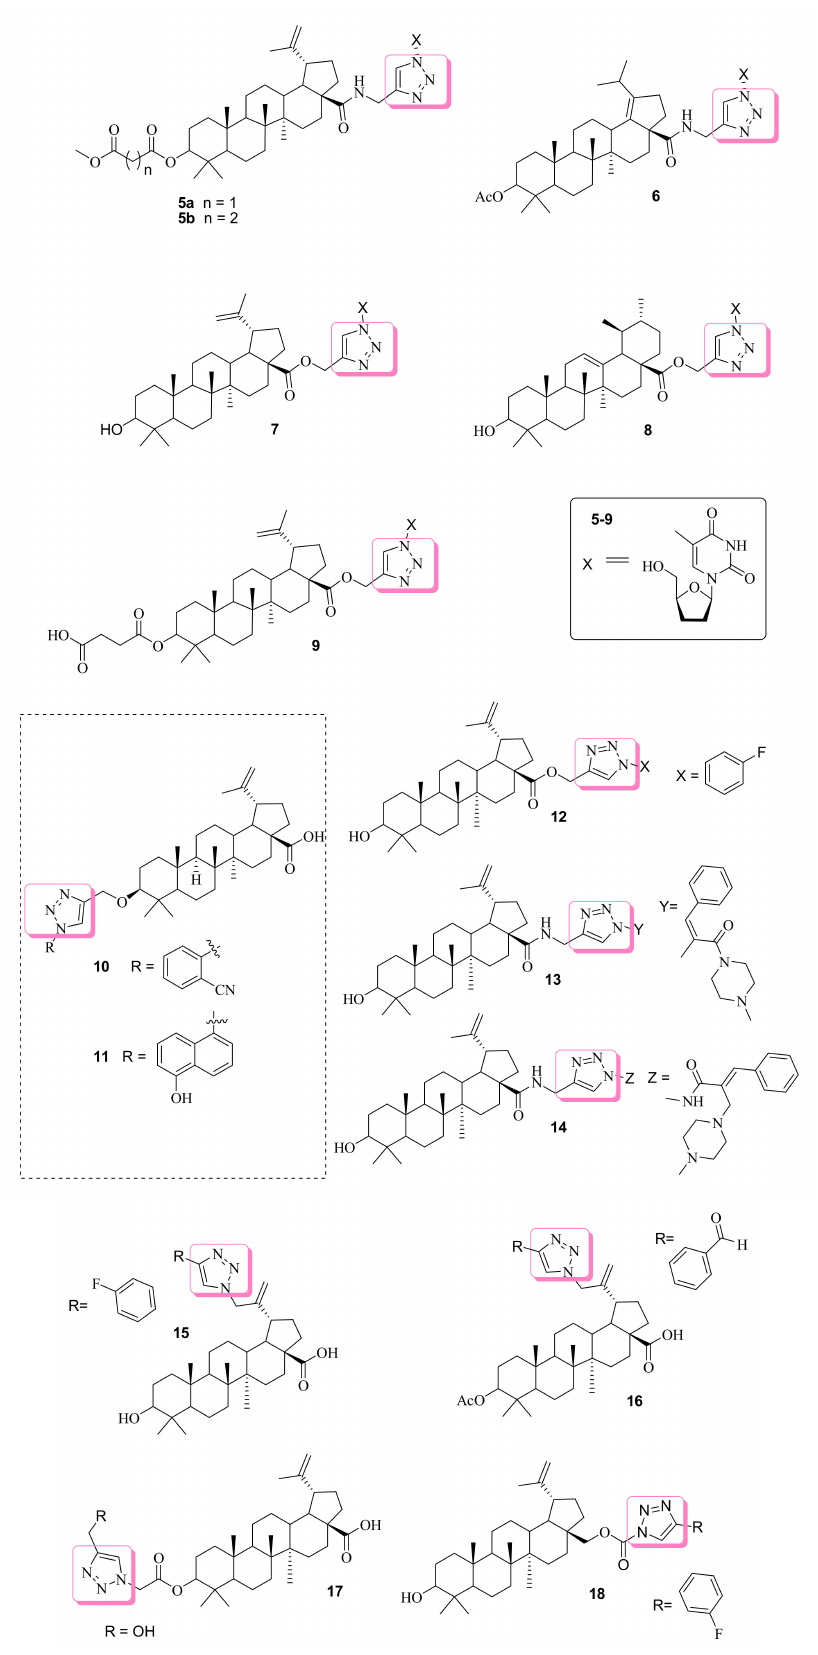
Figure 2. Betulinic acid-based 1,2,3-triazole